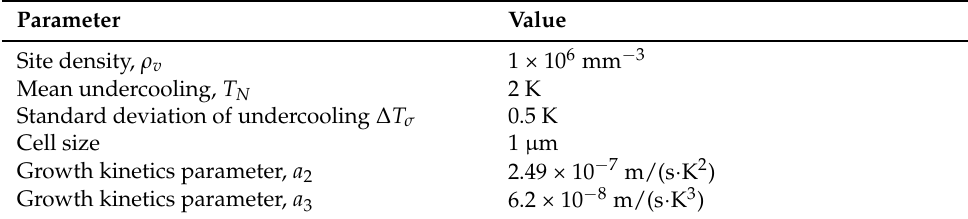
Table 3. Nucleation parameters for the CA model [45].